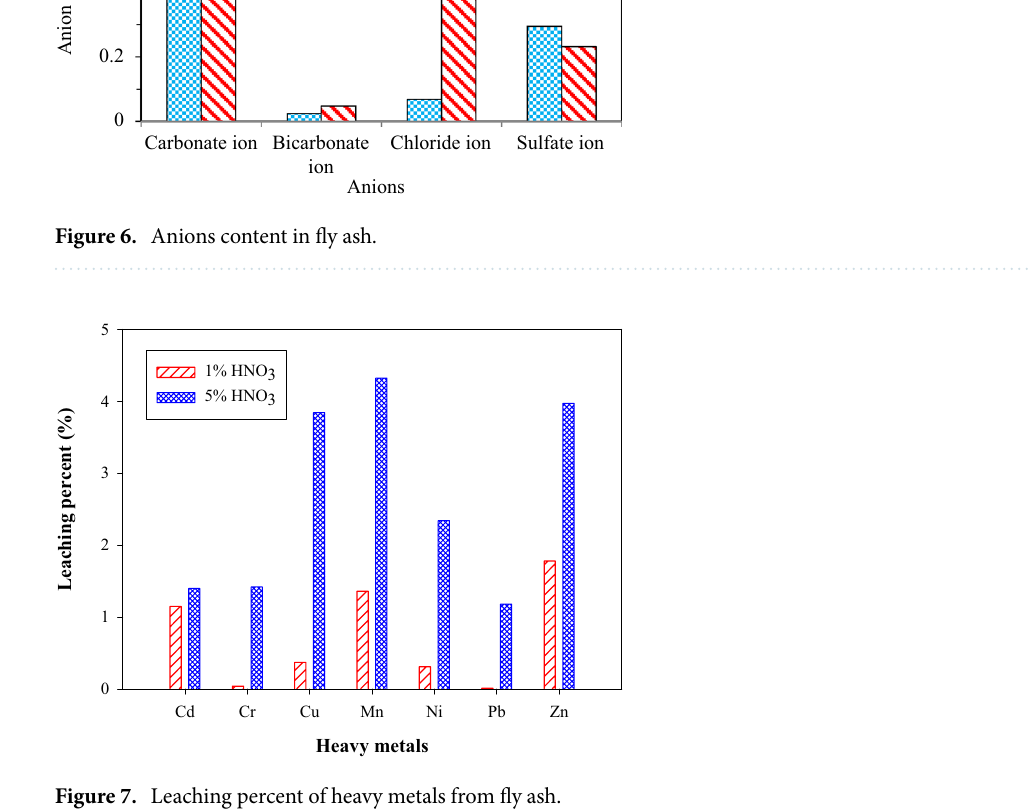
Figure 7. Leaching percent of heavy metals from fly ash.